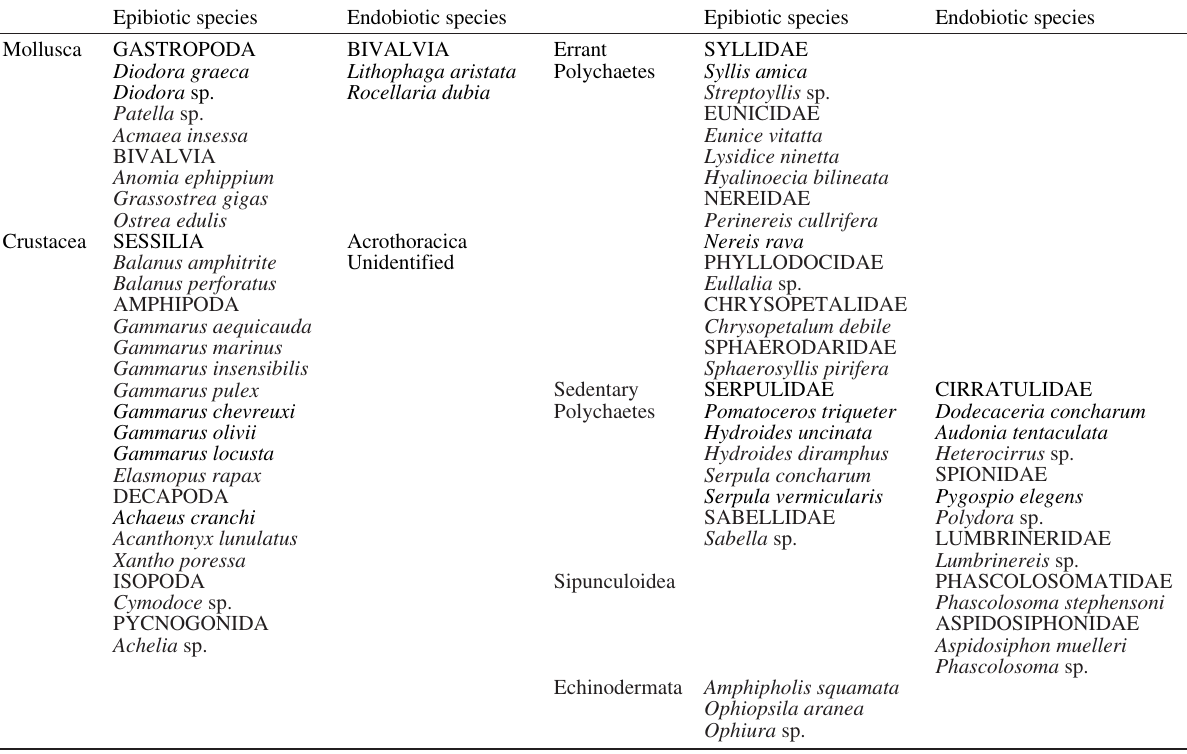
Table 2. – Fauna associated with Stramonita haemastoma collected from Bizerta Channel (northern Tunisia). Epibiotic species Endobiotic